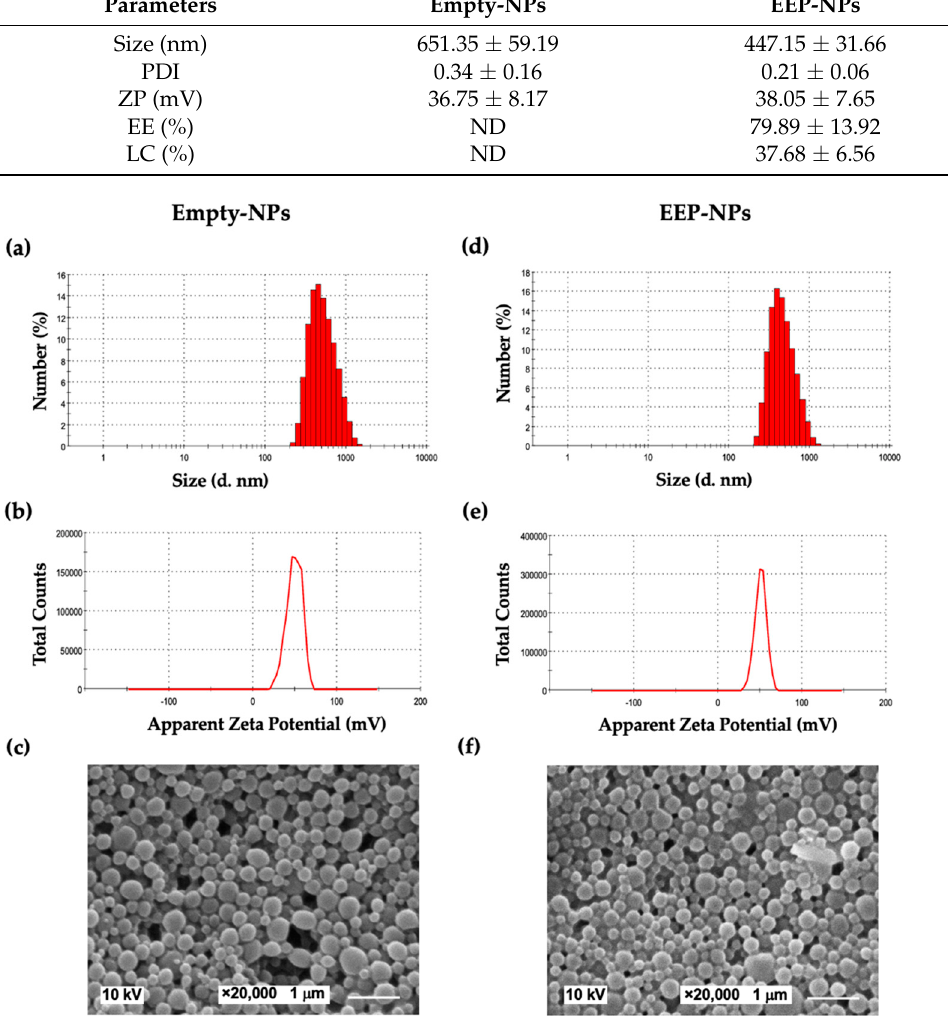
Figure 1. Characteristics of the NPs. Morphology images, size distribution and ζ potential (ZP) curves of the Empty-NPs ( a – c ) and the EEP-NPs ( d – f ). The scale bar represents 1 μ m.